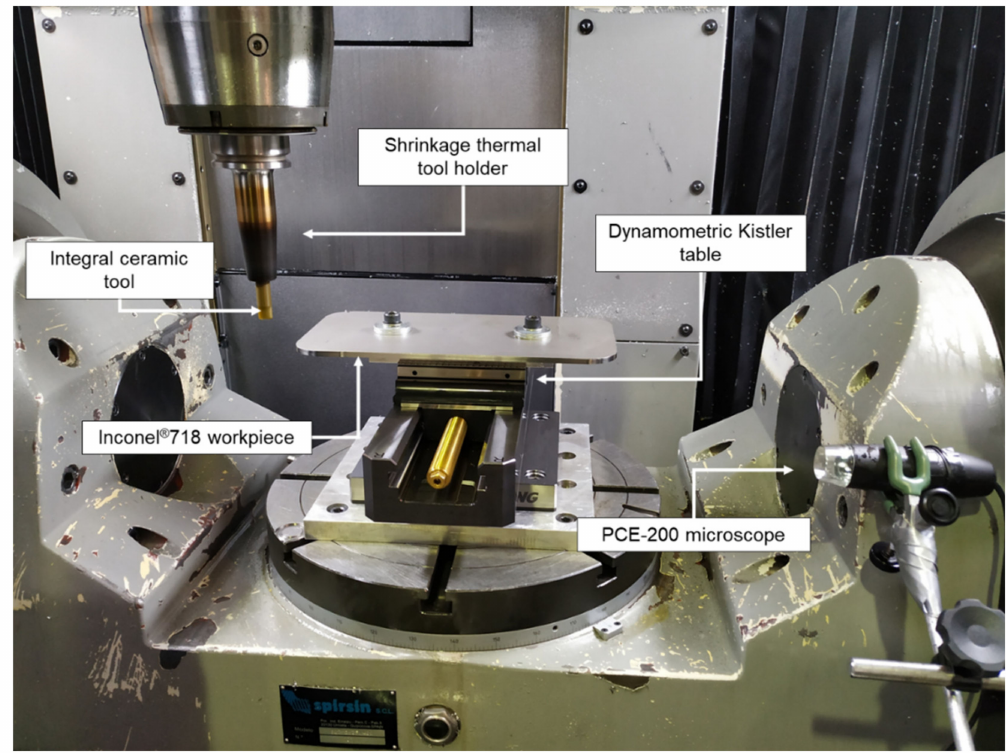
Figure 1. Experimental setup in the milling